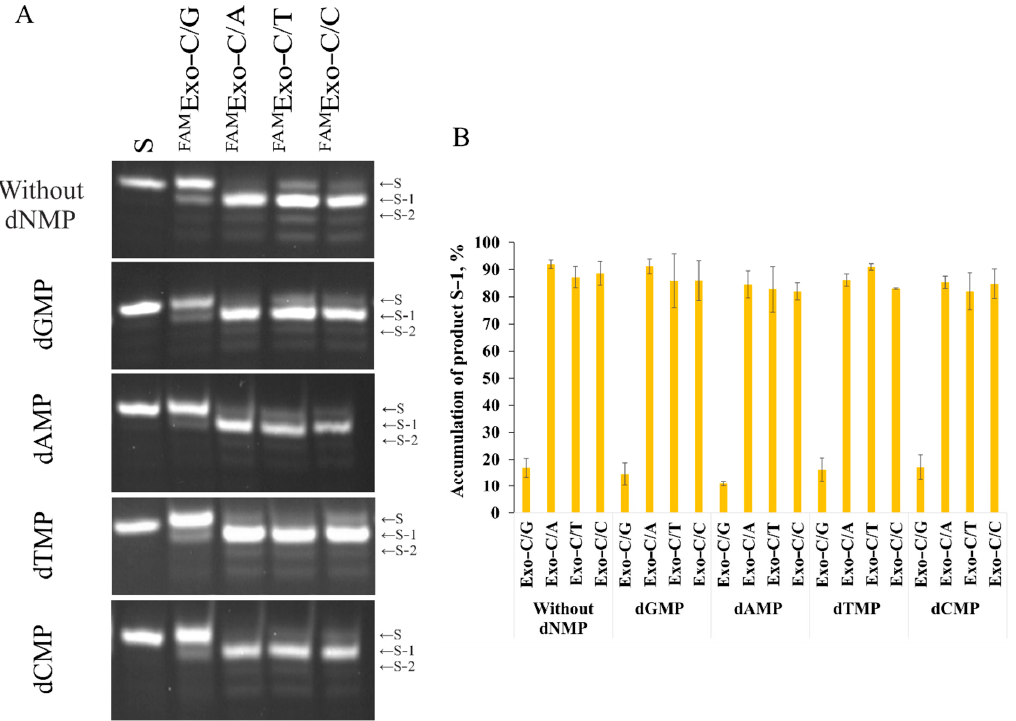
Figure 5. ( A ) Incubation of Apn2 with dNMP ([Apn2] = [S] = 1 μ M, [dNMP] = 5 mM, T = 37 °C, t reaction = 10 min). ( B ) The histogram of the accumulation of product S–1 in the presence of dNTP.